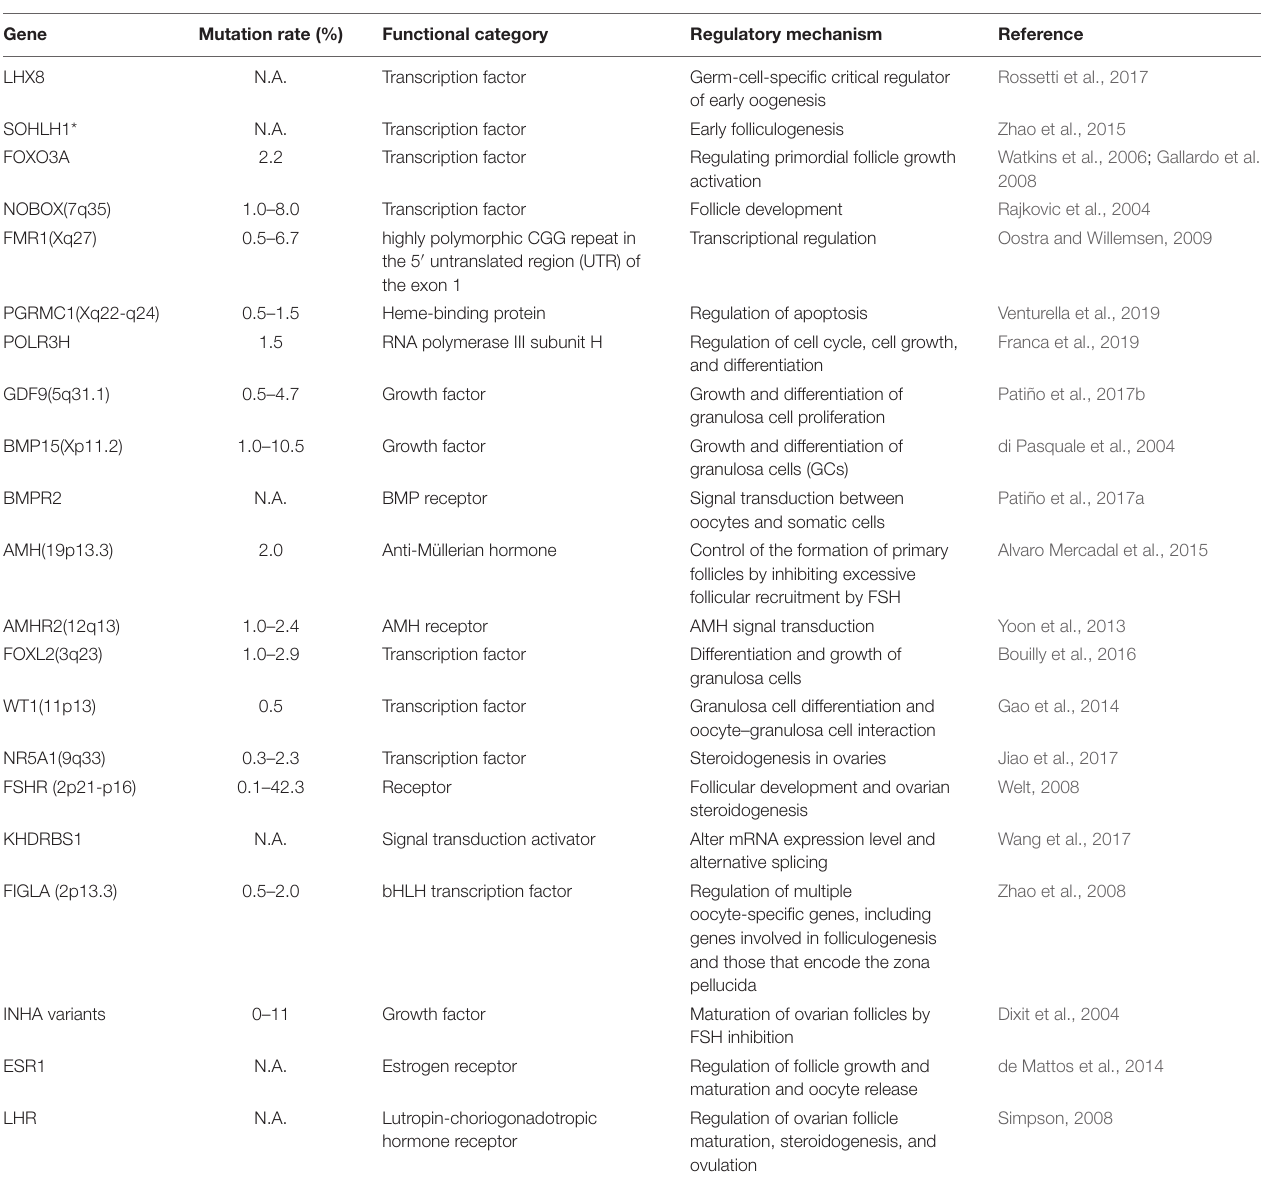
TABLE 2 | Causative genes in